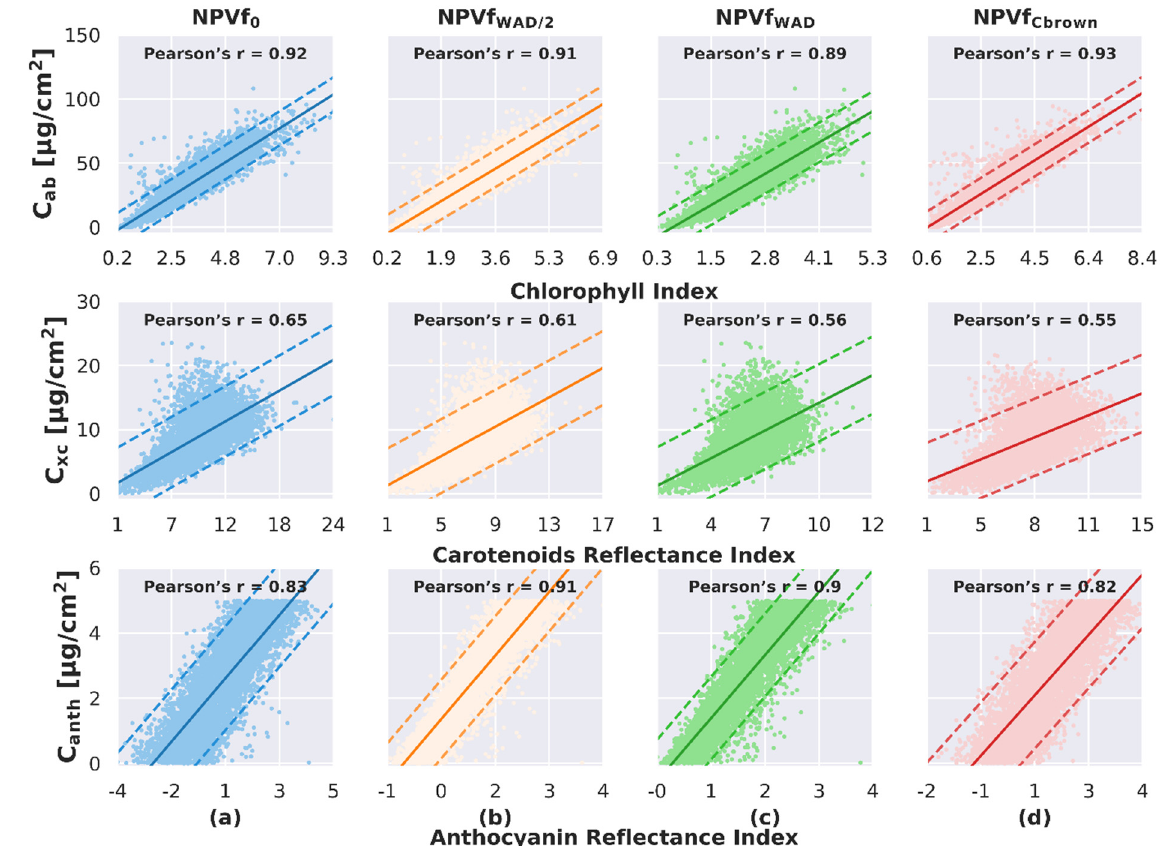
Figure 6. Relationship between spectral indices and leaf chemistry obtained from DART simulation on site A. ( a ) NPVf 0 ; ( b ) NPVf WAD ; ( c ) NPVf WAD/ 2 and ( d ) NPVf Cbrown . Top: C ab and CI ; middle: C xc and CRI : and bottom: C anth and Anthocyanin Reflectance Index ( ARI ).